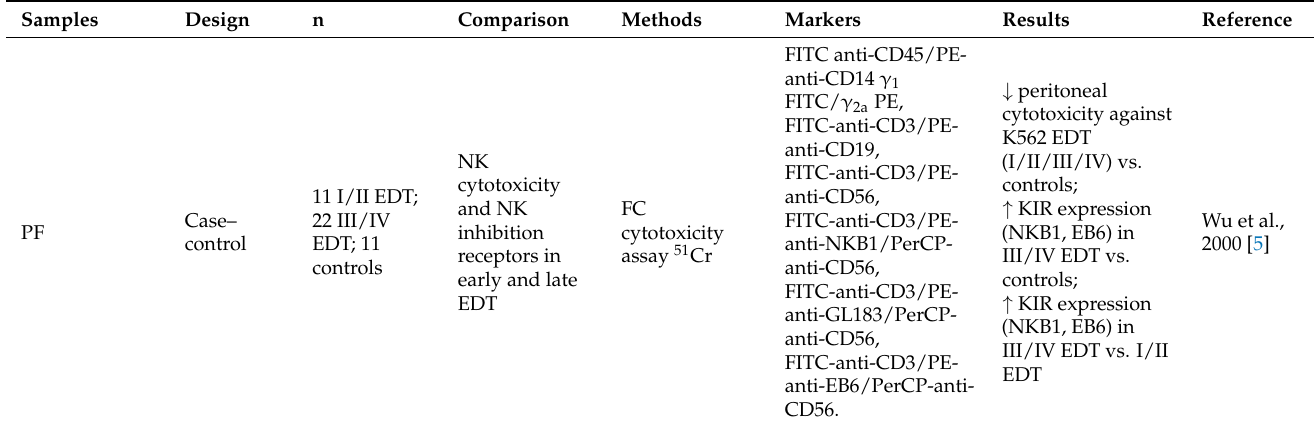
Summary of findings and methods of selected studies regarding NK cell- activating/inhibiting receptors in